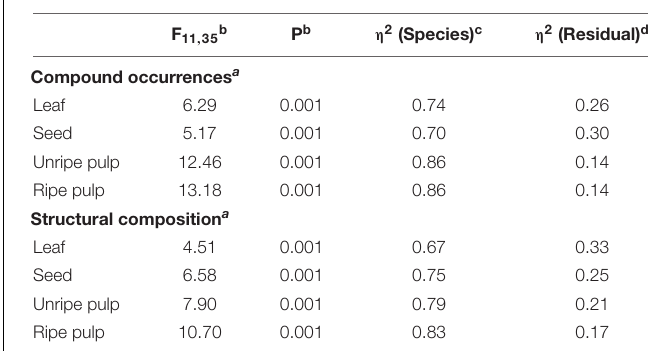
TABLE 4 | Results from PERMANOVAs showing a large percentage of sample-to-sample variance in composition within organ types (i.e., beta diversity) is explained by